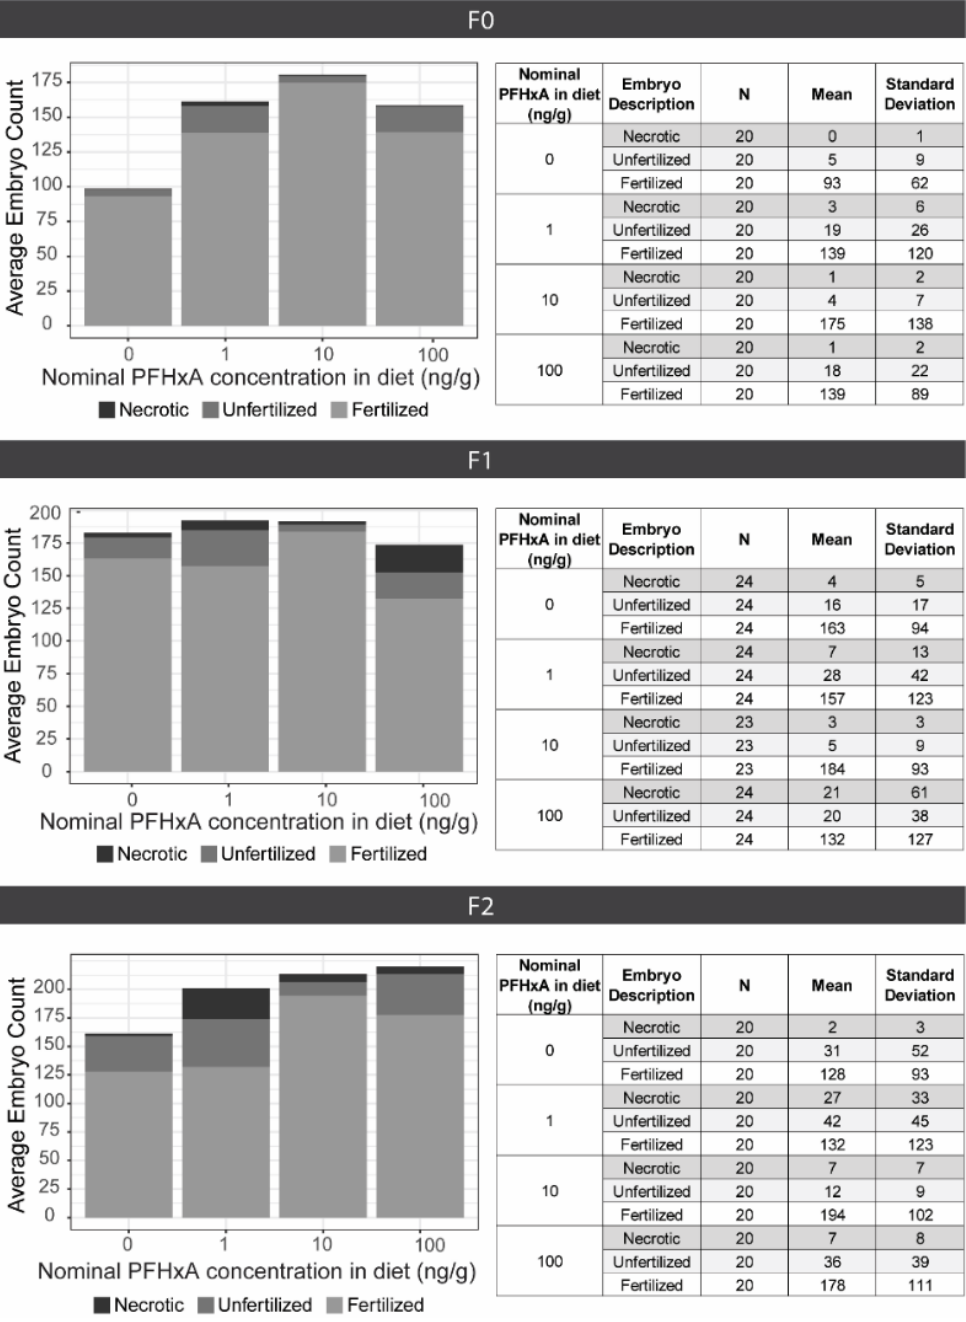
Figure 3. Fecundity Assessments. 4 groups of 3 male and 2 female zebrafish were spawned for 5–6 consecutive spawning events per generation (top: F0, middle: F1, bottom: F2). The average embryo counts are plotted on the left, including necrotic (black), unfertilized (dark grey), and fertilized (light grey) embryos for each exposure group (0, 1, 10, or 100 ng/g PFHxA added to the F0 diet). The tables on the right indicate the evaluated number of spawns (N), mean counts, and standard deviation.